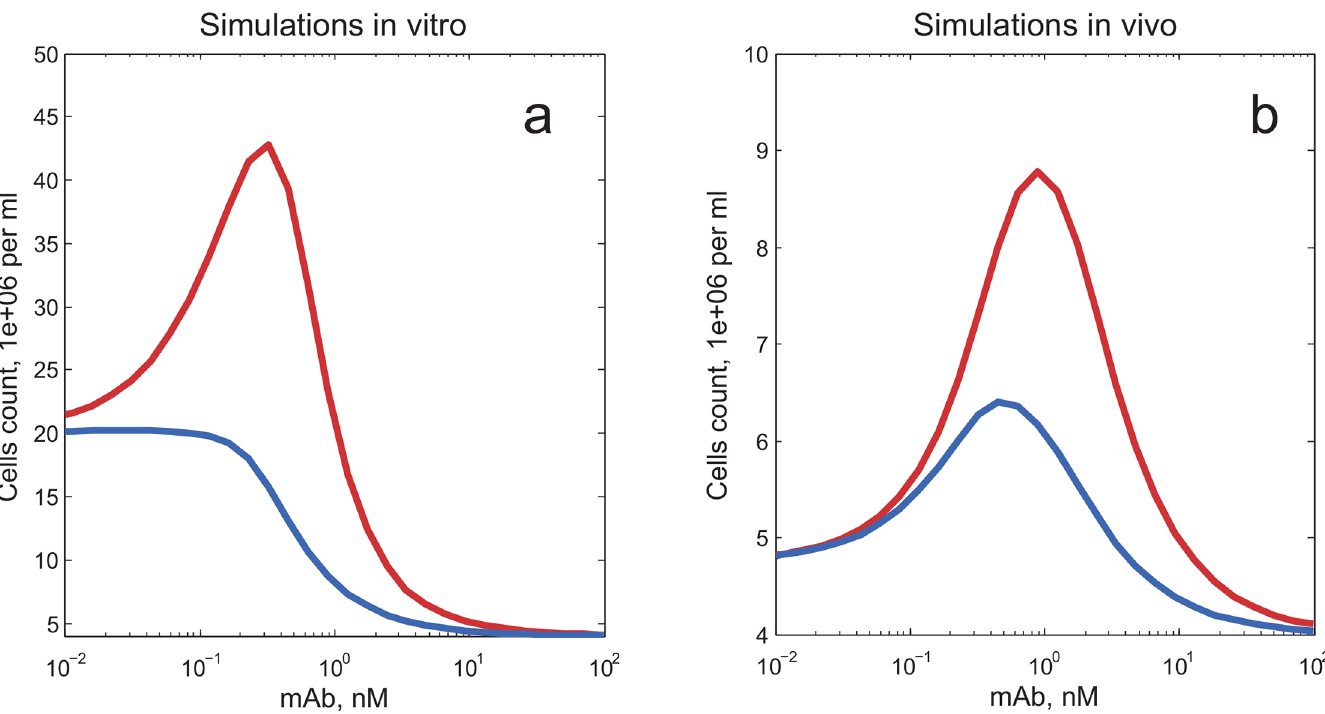
Fig 5. Agonistic effect of an IL-4 neutralizing mAb: model simulations for an in vivo case vs . an in vitro case. Red lines are for the α -chain blocking mAb, blue lines are for the γ -chain blocking mAb. (a) simulations for the in vitro case, (b) simulations for the in vivo case. The following experimental conditions were used in the model simulations: incubation time = 3 days; initial concentration of IL-4 = 250 pM; initial cells density = 4e+06 cells/ml; mAb/IL-4 binding K D = 20 pM; EC 50 = 20 signaling complexes per cell. For simulations of the in vivo conditions, systemic elimination rates of 1.26 1/h and 0.004 1/h were added, respectively, for IL-4 and the mAb.